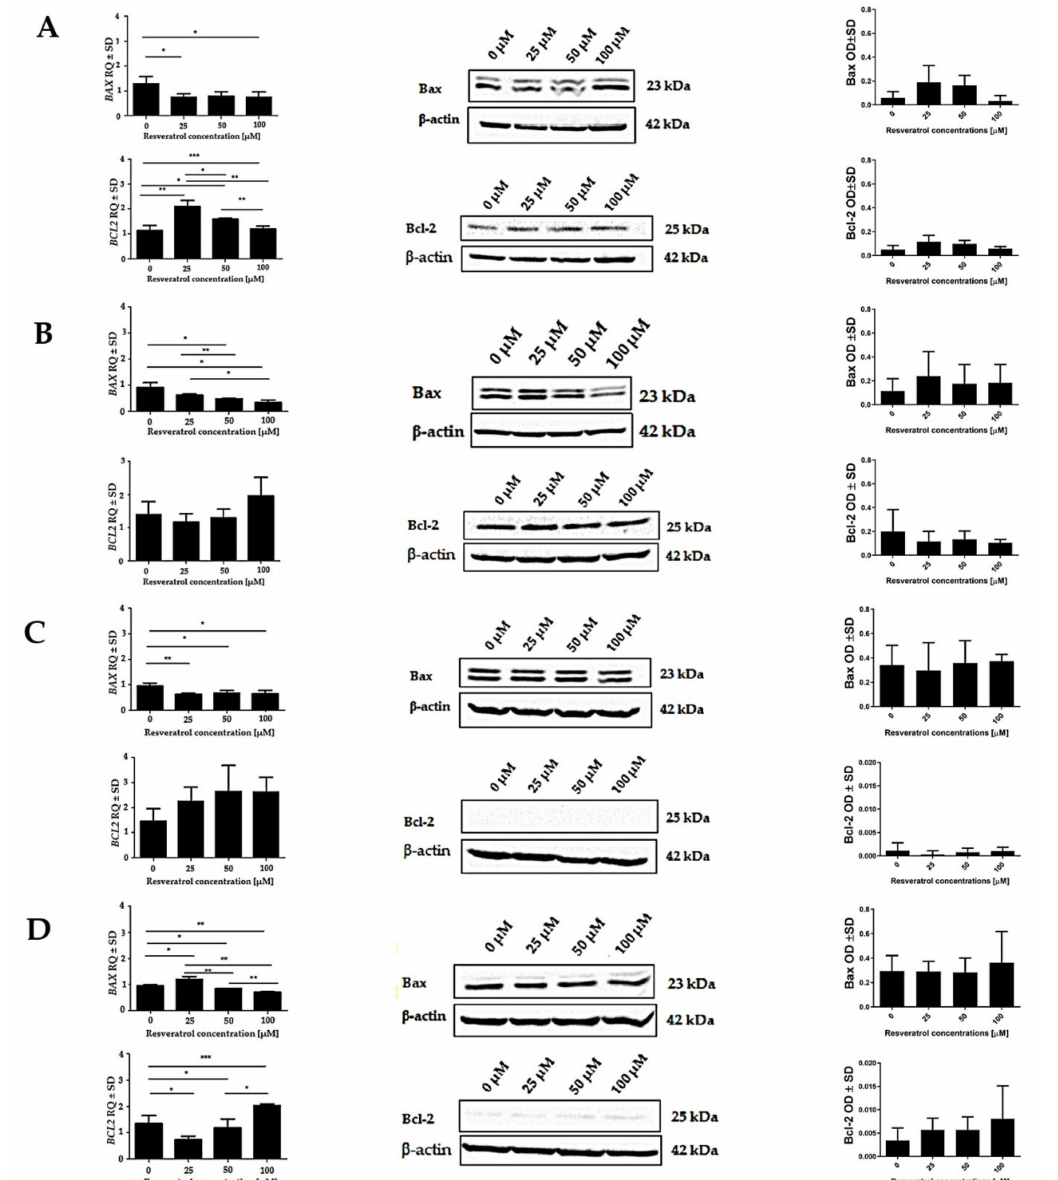
Figure 8. Effect of resveratrol on changes in the expression level of genes and proteins related to the apoptotic process assessed by real-time PCR (left panel) and Western Blot (middle and left panels). The analysis was performed on human pancreatic cell lines after 48 h of exposure to various concentrations of resveratrol. ( A ) EPP85-181P cell line, ( B ) EPP85- 181RNOV cell line, ( C ) AsPC-1 cell line and ( D ) H6c7 cell line; * p < 0.01; ** p < 0.001; *** p <